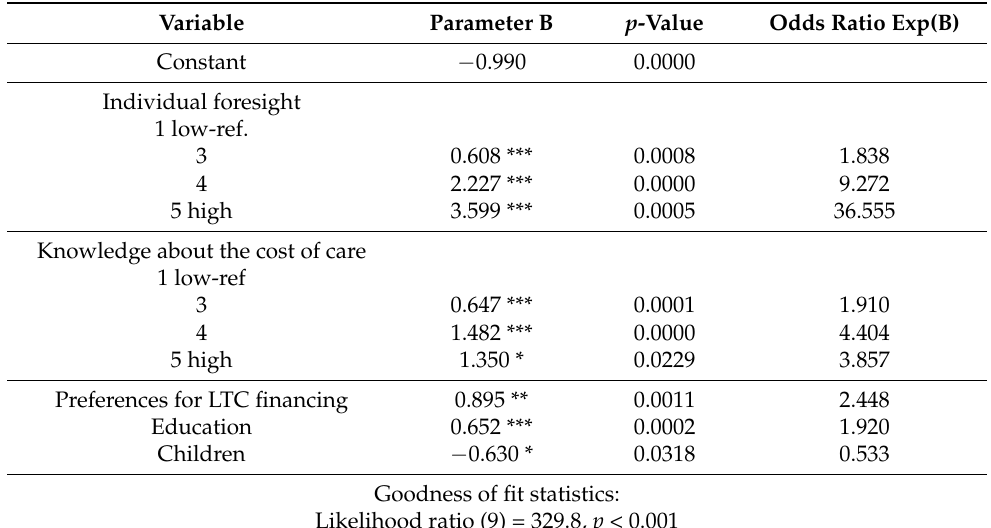
Table 4. Estimation results of the logit model of the propensity to purchase LTCI in